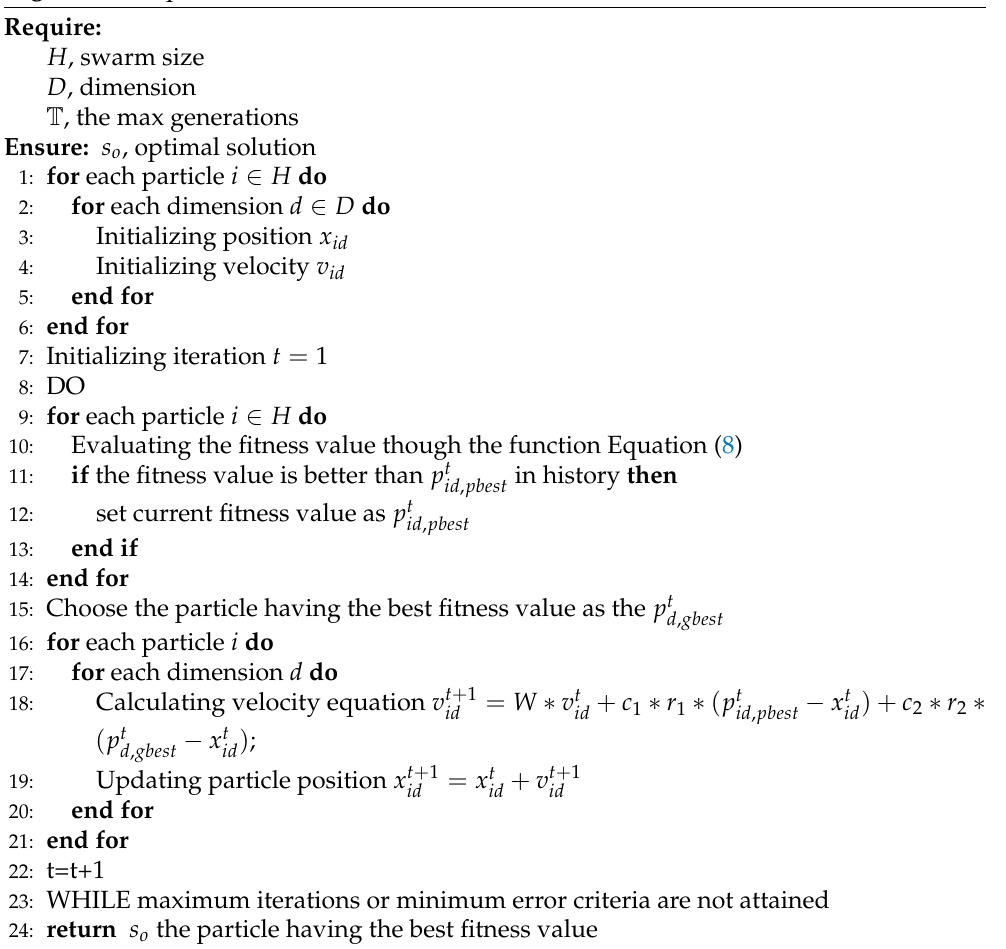
Algorithm 2 Optimization